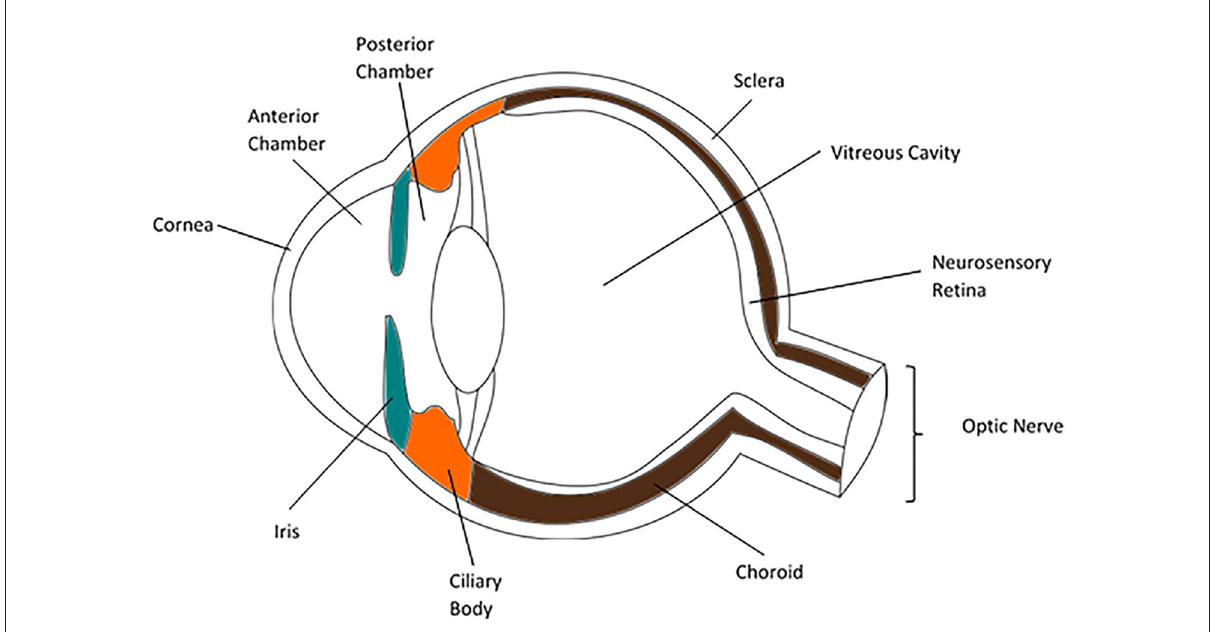
FIGURE1 Anatomy of the human eye